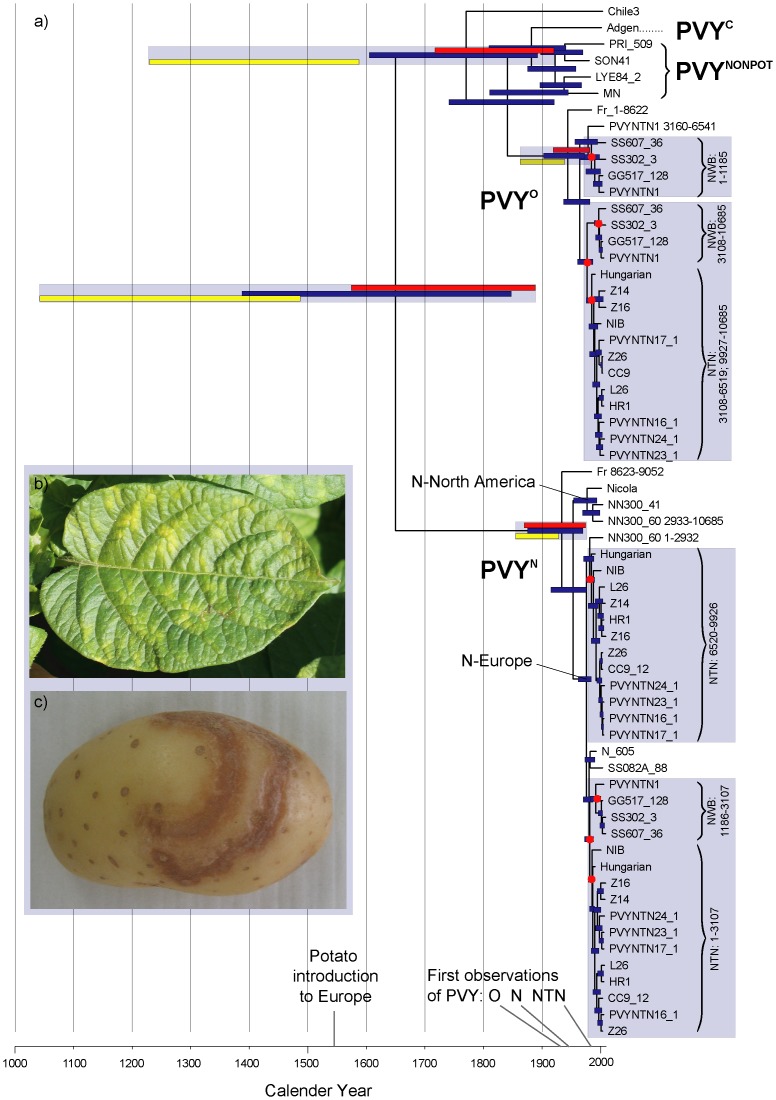
The recent, recombinant origins of Potato Virus Y genomes.The maximum clade credibility tree from the BEAST LN relaxed clock analysis is shown with error bars representing the 95% HPD of node ages according to LN (blue), EX (red) and SC (yellow) models. Recombinant strains such as pathogenic PVYNTN and PVYNW-B are represented as multiple taxa, each representing a subset of the alignment (as indicated) with distinct phylogenetic signal. Topology constrained nodes are indicated with red dots. Inset: a potato leaf showing mosaic patterns and tuber with potato tuber necrotic ring disease resulting from PVY infection.